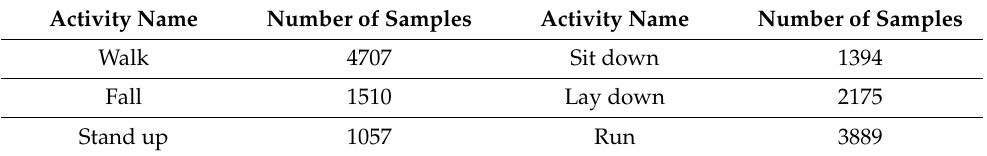
Table 2. Summary of the StanWiFi